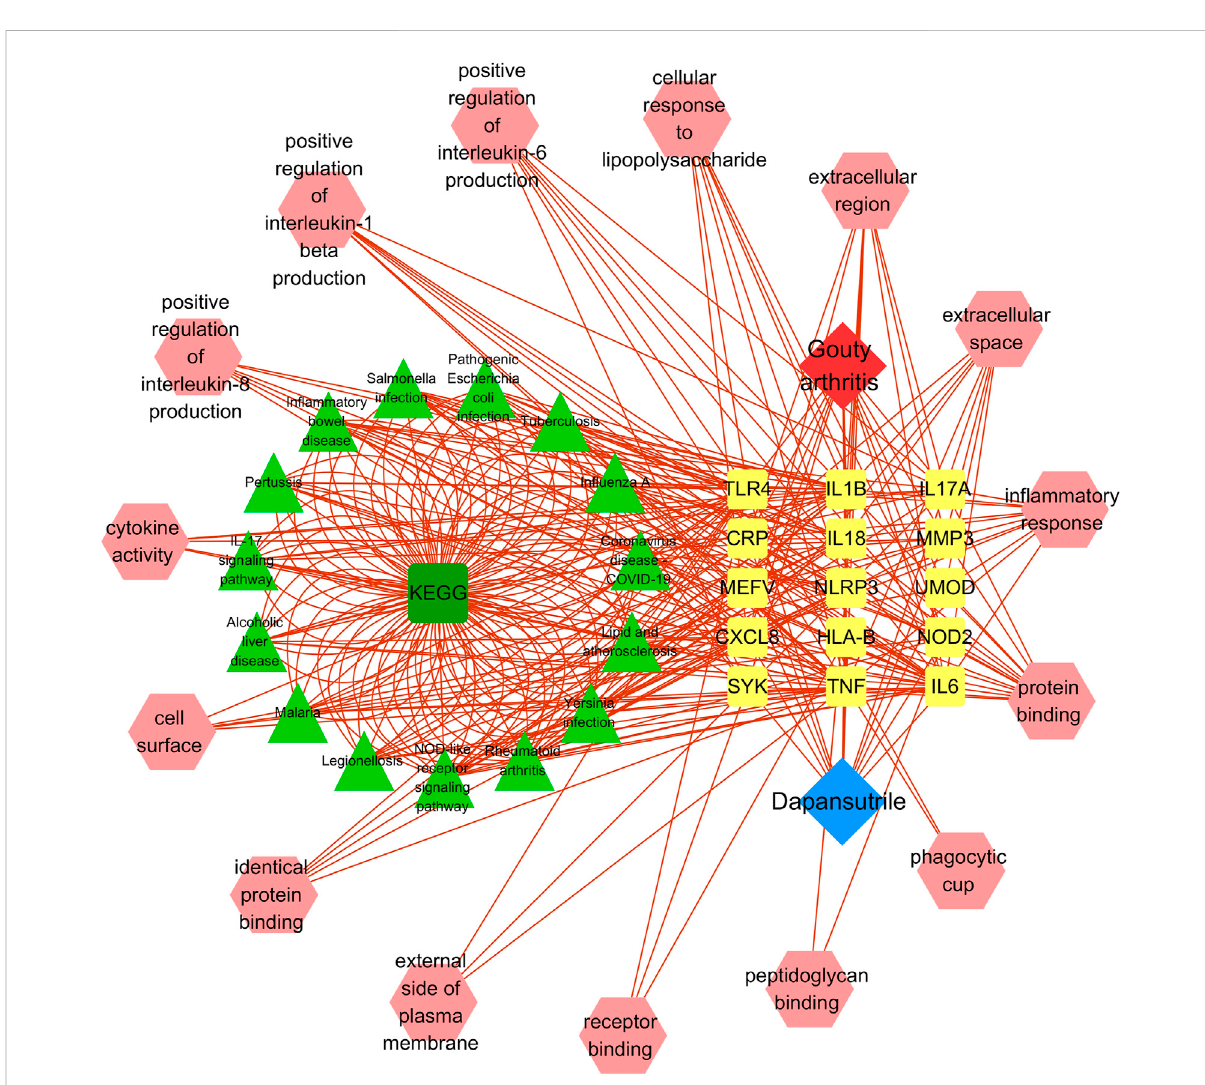
FIGURE 3 Disease-core gene target-drug network. Square nodes represent gene targets, triangular nodes represent signaling pathways (KEGG), and octagonal nodes represent gene ontology (GO) of related